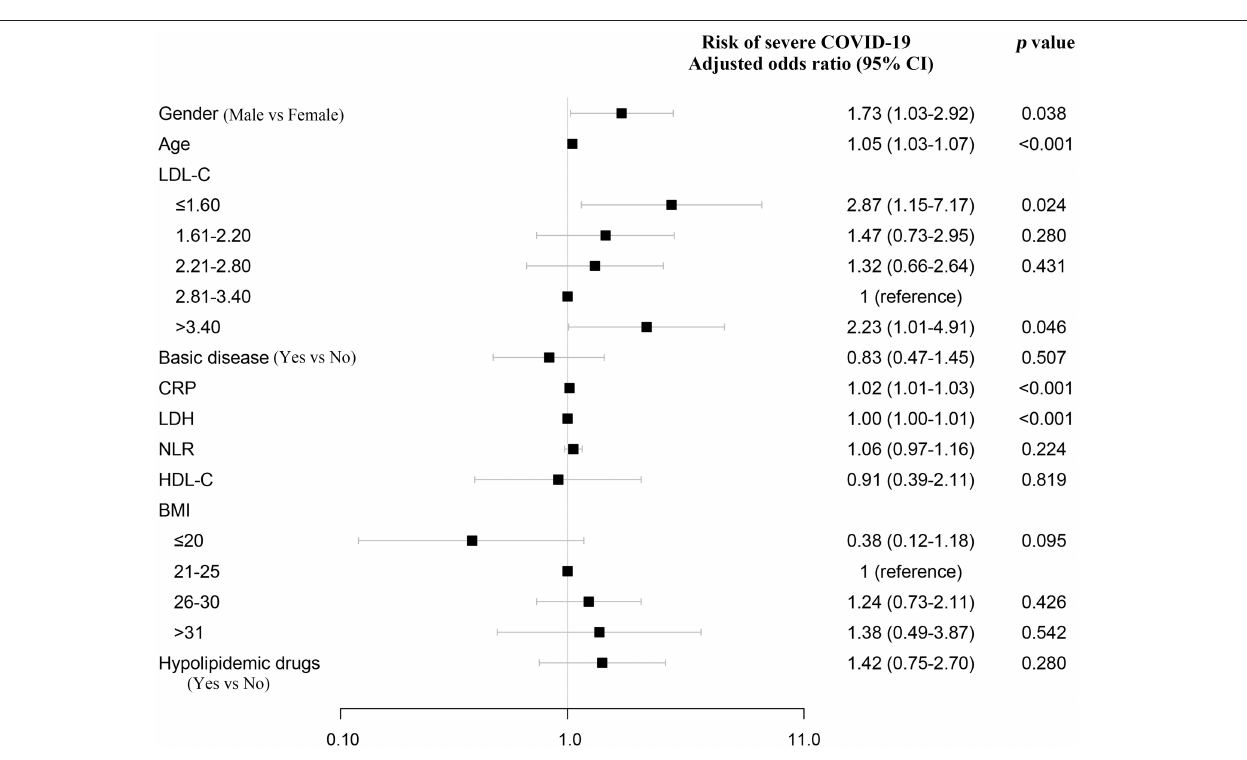
FIGURE 5 | Sensitivity analysis. Sensitivity analysis that additionally adjusted for age, gender, basic disease, CRP, LDH, NLR, HDL-C, BMI, and hypolipidemic drugs. Odds ratios were from multivariate logistic regression analysis. NLR, neutrophil-to-lymphocyte